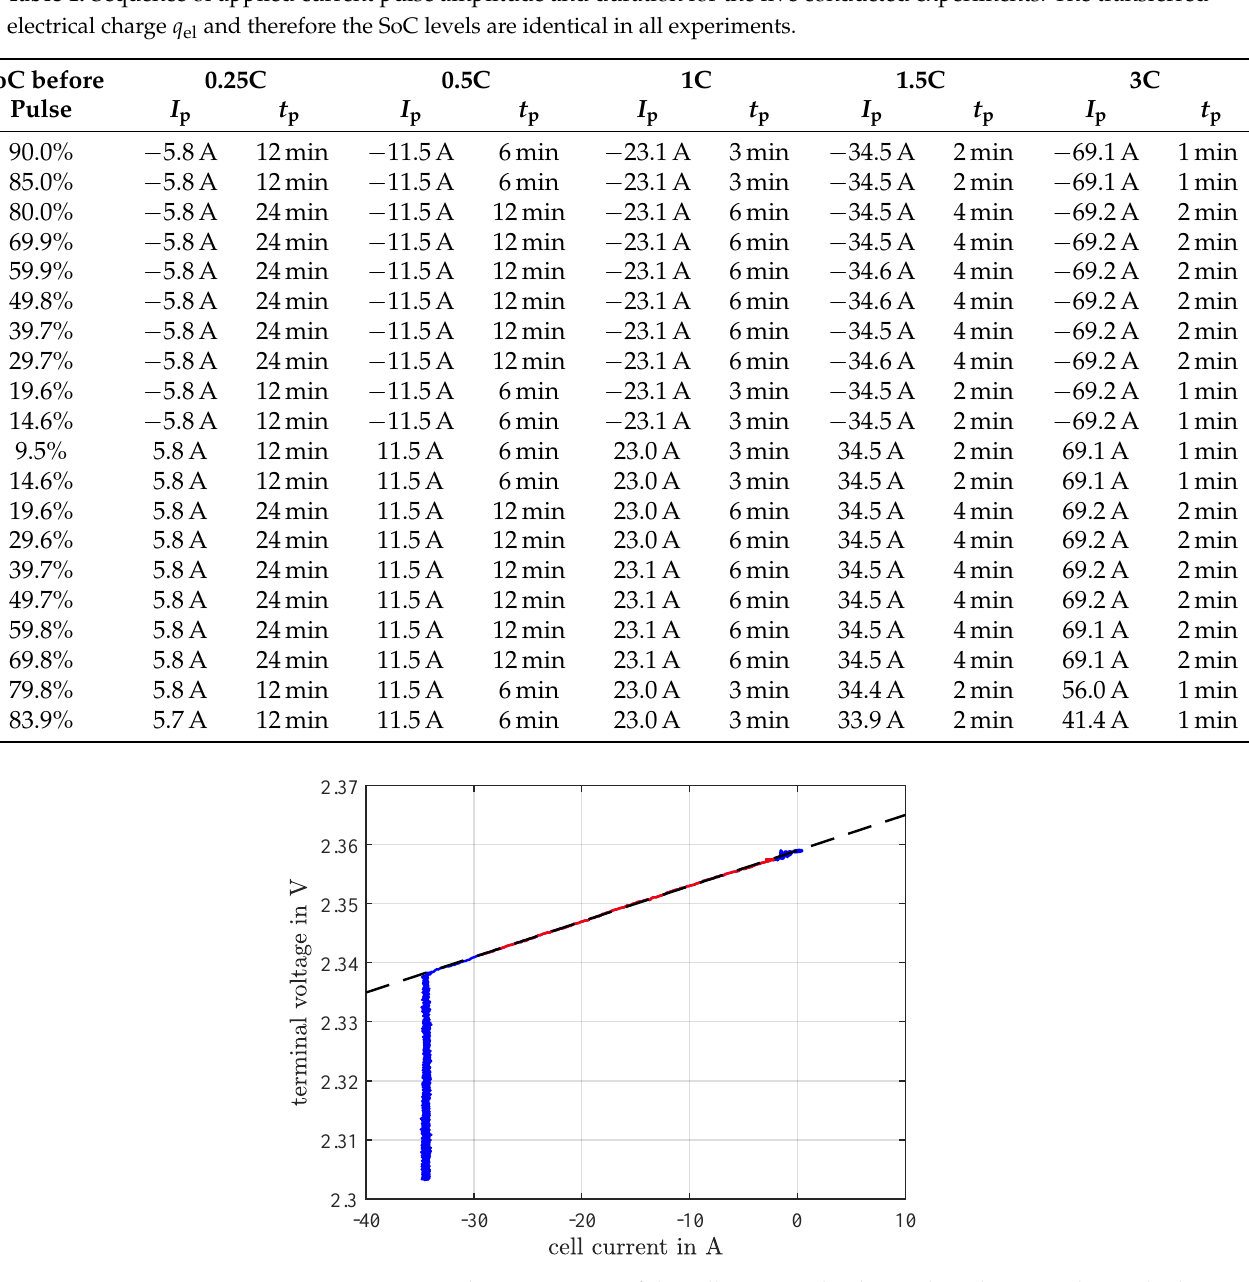
Figure 2. Hi–speed measurement of the cell’s terminal voltage plotted against the applied current (blue), with the ramp-up section (red) used to determine the slope by means of a linear regression (dashed